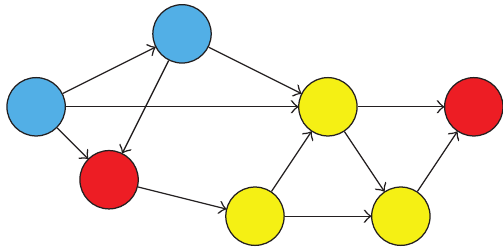
Figure 5: Mapping of the initial application graph.